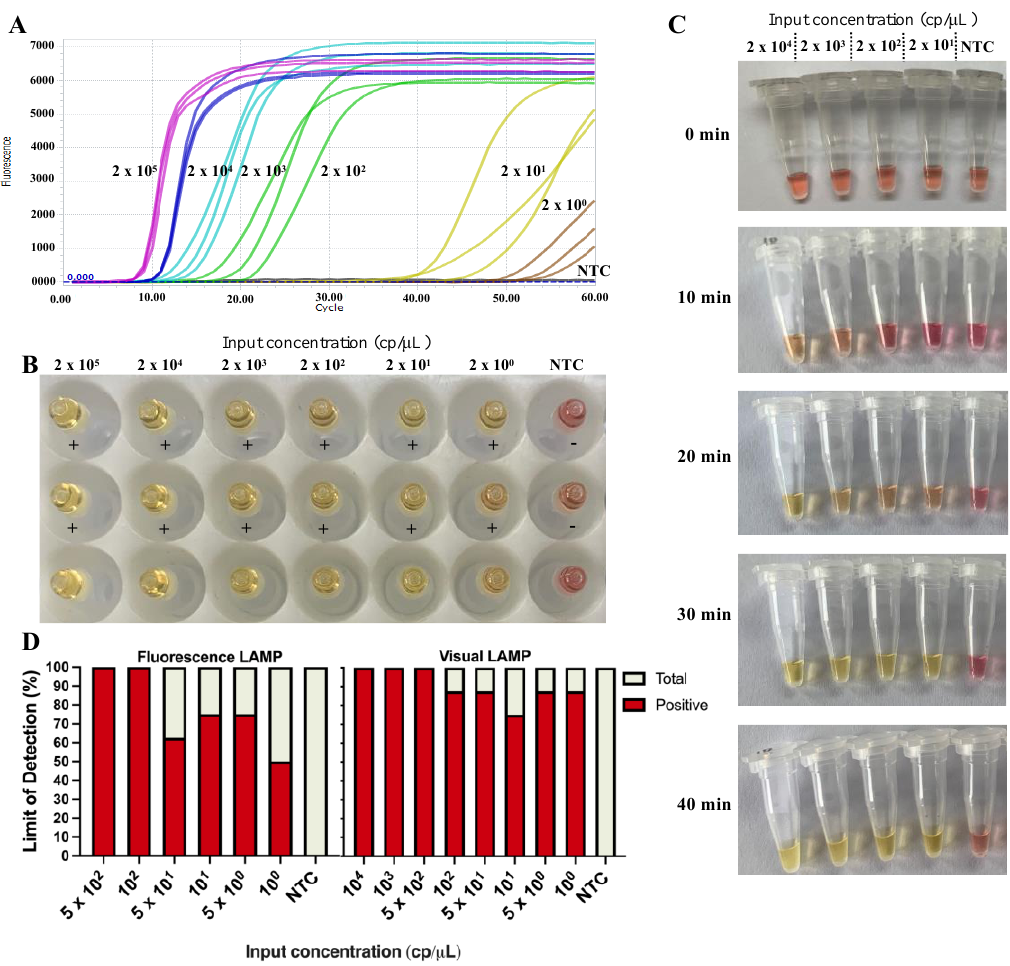
Figure 2. Sensitivity of the mpox LAMP assay as determined using a serially diluted DNA standard plasmid ranging from 2 × 10 5 to 2 × 10 0 copies. ( A ) the sensitivity of the fluorescent LAMP assay was monitored by real-time instrument. ( B ) The sensitivity of the visual LAMP assay was evaluated by a change of color from pink to yellow. ( C ) Determination of reaction time of visual LAMP for positive amplification that was assessed using the serially diluted DNA standard plasmid from 2 × 10 4 to 2 × 10 1 copies. Observation of color change from pink to yellow indicates a positive reaction. ( D ) Limit of detection (LOD) of the fluorescent LAMP assay was assessed using DNA standard plasmid from 5 × 10 2 to 1 × 10 0 copies dilutions in eight repetitions, carried out at 65 ◦ C for 60 min incubation, whereas the LOD of visual LAMP using DNA standard plasmid from 1 × 10 4 to 1 × 10 0 copies was assessed in eight replicates, carried out at 65 ◦ C for 60 min incubation. NTC: non-template control.